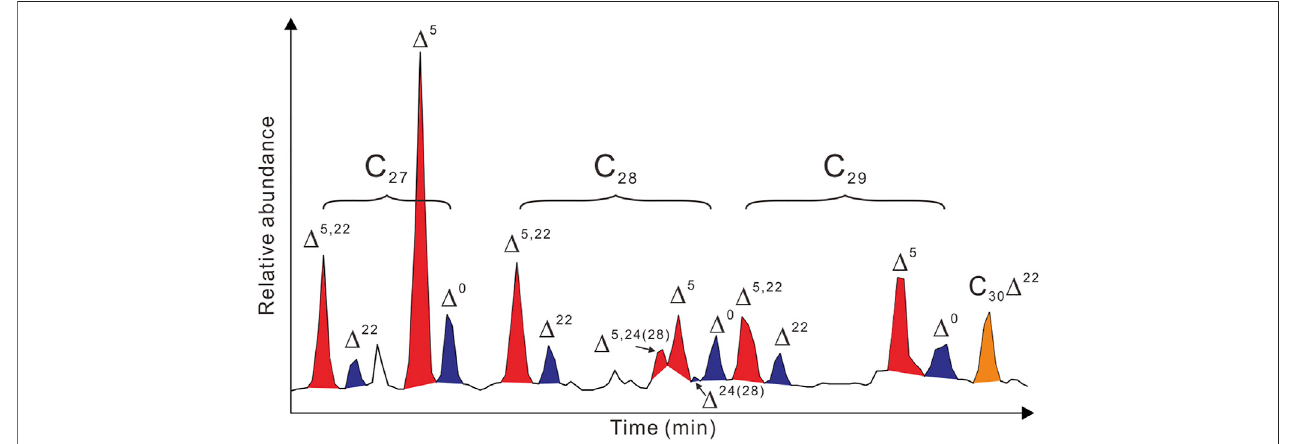
FIGURE 2 | Partial total ion chromatogram (TIC) of the alcohol fraction in core S401 sediments. Most of the sterols and stanols with abbreviation are labeled in the fi gure. The systematic and trivial names of each compound are present in Table 2 ; more detailed information can be found in published studies (e.g., Rampen et al., 2010; Nakakuni et al., 2017; Nakakuni et al., 2018).